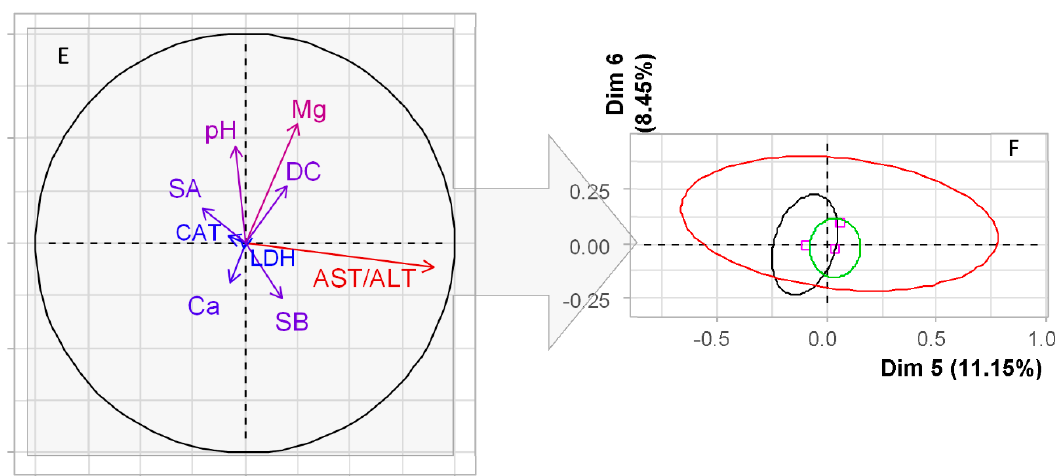
Figure 1. Principal component analysis (PCA)—Factor plane ( B , D , F ) and the corresponding correlation circle ( A , C , E ) in the first five dimensions for three groups (lung cancer without COPD, lung cancer with COPD I, lung cancer with COPD II). The color of the arrows on the correlation circle changes from blue (weak correlation) to red (strong correlation), as shown on the color bar. The orientation of the arrows characterizes positive and negative correlations (for the first principal component, we analyze the location of the arrows relative to the vertical axis, for the second principal component—relative to the horizontal axis). LDH—lactate dehydrogenase; CAT—catalase; SB—Schiff bases; DC—diene conjugates; SA—sialic acids; Ca—calcium; Mg—magnesium; AST/ALT—aspartate aminotransferase to alanine aminotransferase ratio.